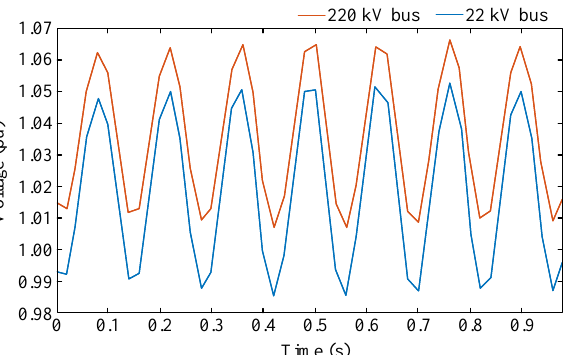
Figure 1. Sustained voltage oscillations in the West Murray area during a planned outage of a transmission line (plot drawn with data from